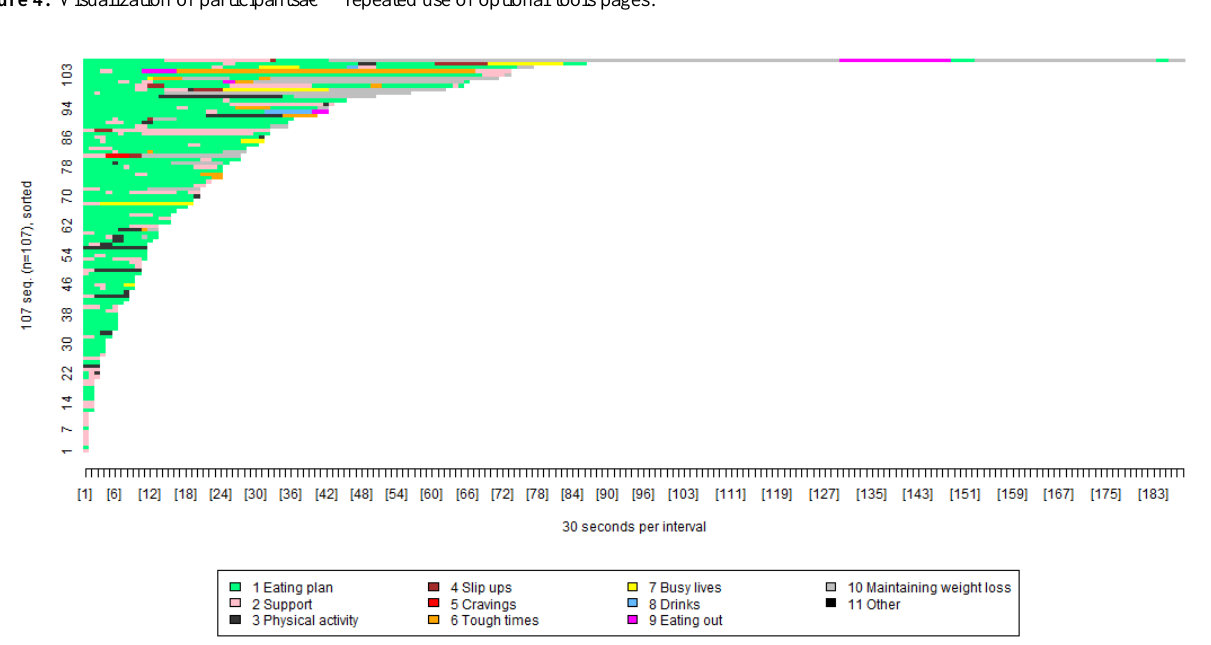
Figure 4. Visualization of participantsâ€™ repeated use of optional tools